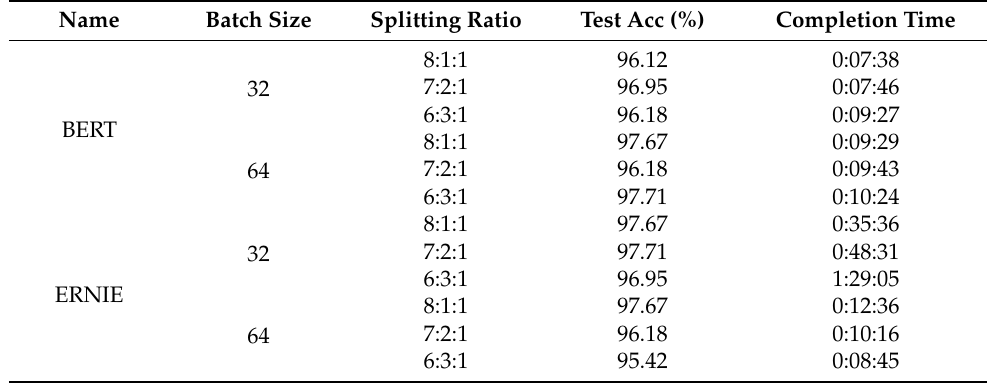
Table 5. Text Acc and completion time of